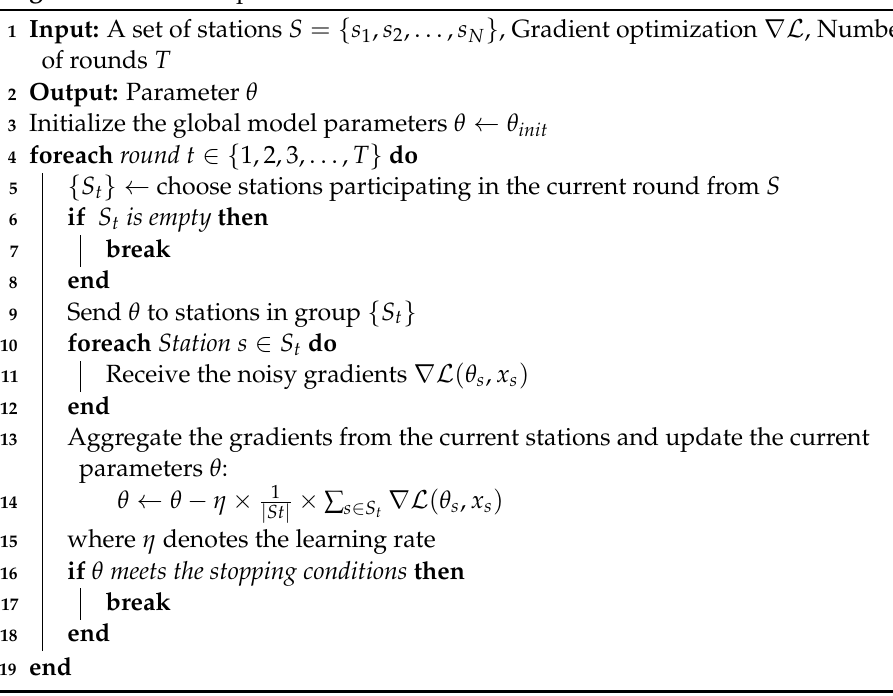
Figure 2. An overview of FL-LDP system: ( 1 ) Server initializes parameters θ 0 , ( 2 ) Clients compute gradients updates on local stored data, ( 3 ) Clients perturb the gradient parameters, ( 4 ) The server computes the client gradients to get the new model, ( 5 ) The aggregated model is return to clients, and then the start the next iteration. Algorithm 1: FL-LDP protocol: Server